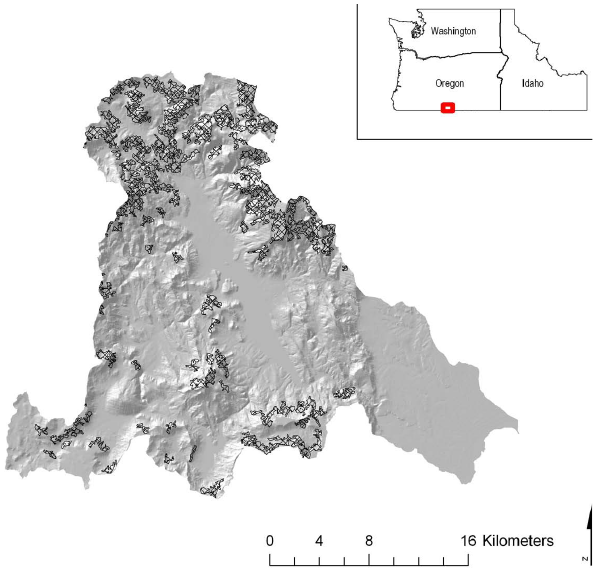
Fig. 1. Vicinity and relief map for the 68474ha Drews Creek watershed, Fremont-Winema National Forest. Stands selected for fuel treatments are hatched